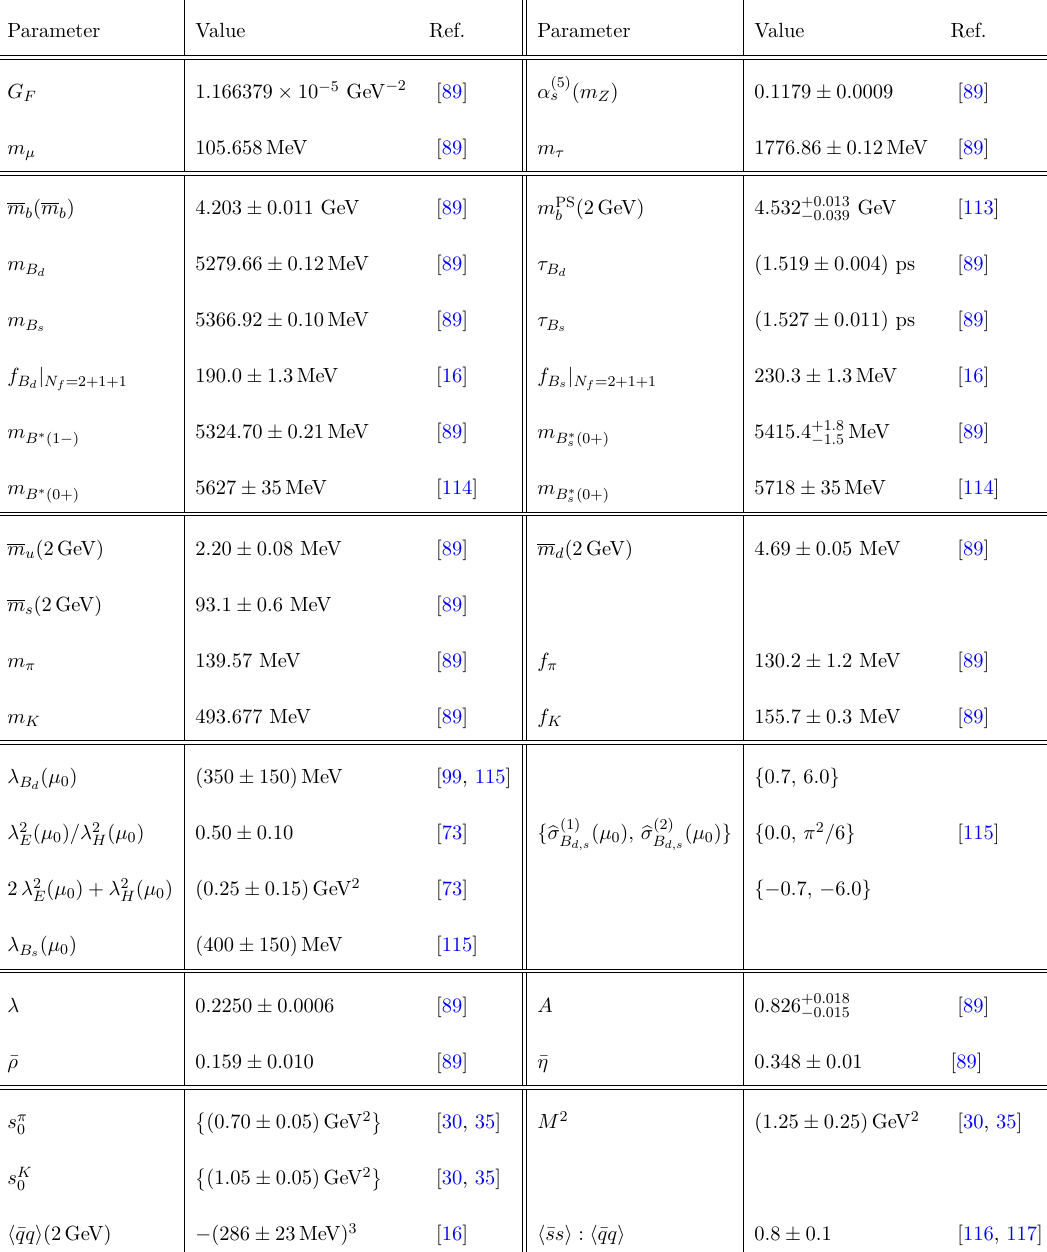
Table 1 . Numerical values of the theory input parameters employed in the LCSR determinations of the exclusive B form factors as well as the subsequent phenomenological analysis for the d,s → π, K semileptonic bottom-meson decay